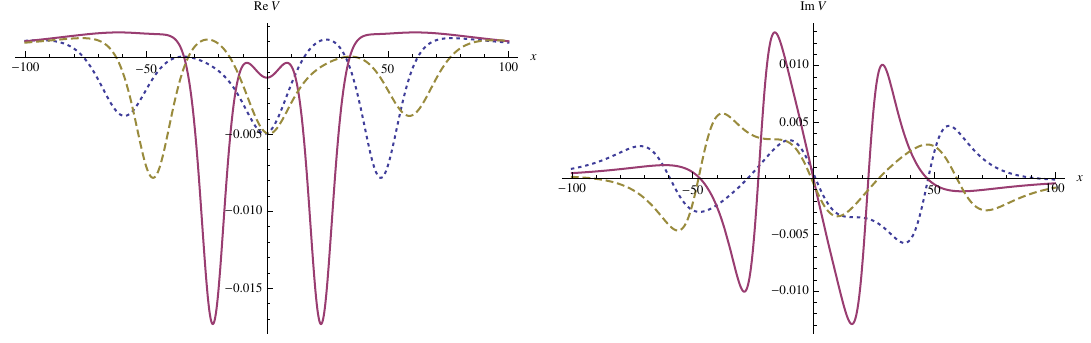
Figure 6 . Evolution of real (on the left) and imaginary (on the right) parts of potential (2.39), (2.42) as a complex -symmetric solution to eq. (2.39) at α = 20, ν = 25; dashed lines: t = PT continuous lines: t = 0, dotted lines: t = 10 6